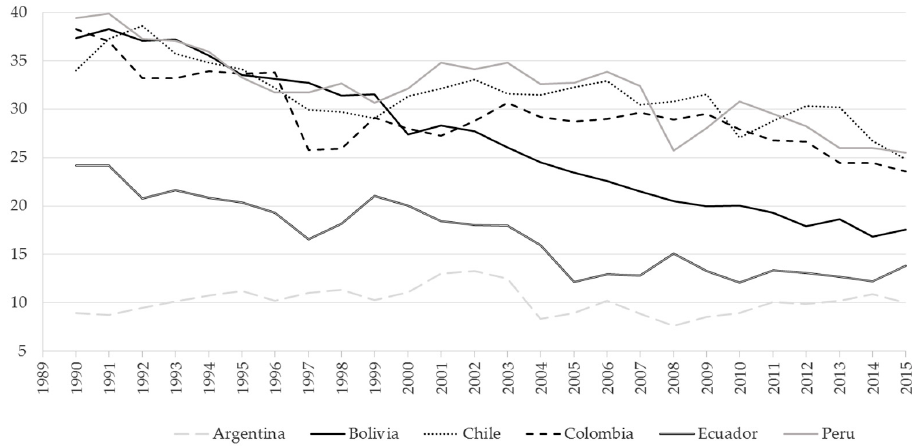
Figure 5. Percentage of renewable energy consumption over total consumption. Source: Energy Information System of Latin America and the Caribbean (sieLAC) of the Latin American Energy Organization (OLADE) [41].